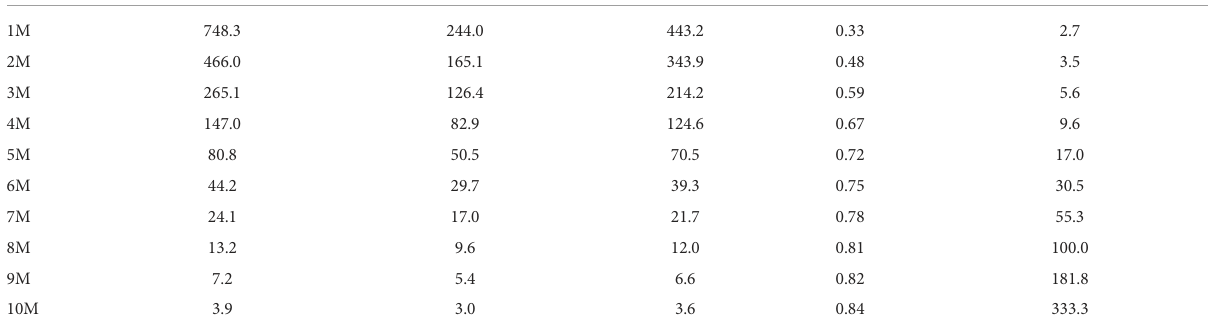
TABLE 4 The illumination distribution analysis in deep-sea environment.